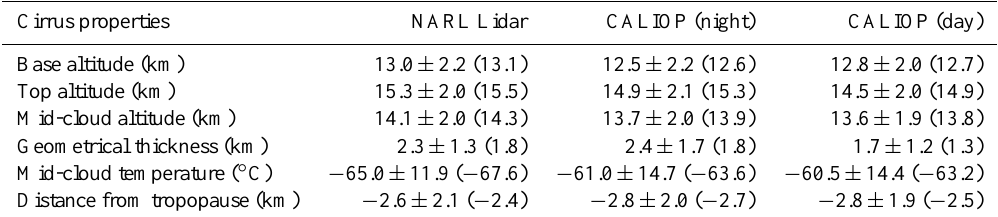
Table 3. Mean, median and standard deviation of macrophysical and thermodynamical properties of cirrus clouds obtained from NARL Lidar and CALIOP over Gadanki. Values in the parentheses represent the median.